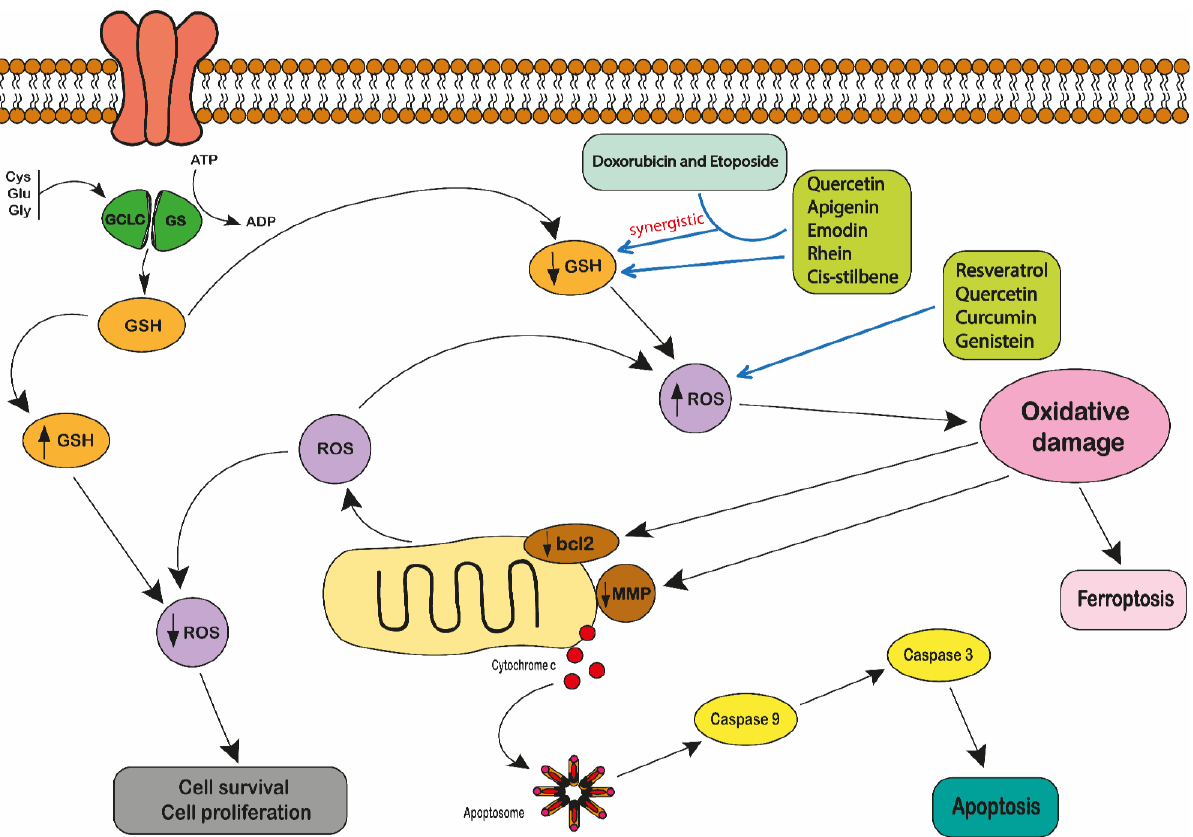
Figure 4. The role of reactive oxygen species (ROS) and glutathione (GSH) in regulation of cell survival and cell death. Glutathione (GSH) (orange) is synthesised from glutamate (Glu), cysteine (Cys) and glycine (Gly) through two ATP-dependent steps. They are catalysed by glutamate-cysteine ligase (GCLC) and then glutathione synthase (GS) (green). Increased GSH levels (orange) lead to reduced ROS (purple) production and results in cell survival. In contrast, GSH depletion leads to increases ROS production, redox status alterations, and consequently cell death, whether apoptosis (blue) or ferroptosis (light pink). Stimulation of reactive oxygen species (ROS) can lead to induction of apoptotic signalling including permeabilisation of the mitochondrial membrane (brown), either directly or through Bcl2 (brown), which results in the release of cytochrome c (red) which in turn activates caspase 9 and 3 (yellow), which mediates cell death. Polyphenols (light green) alone or in combination with chemotherapy agents (light blue) drive an increase in ROS and decrease in GSH levels (blue lines) and cancer cell death via apoptosis or ferroptosis.